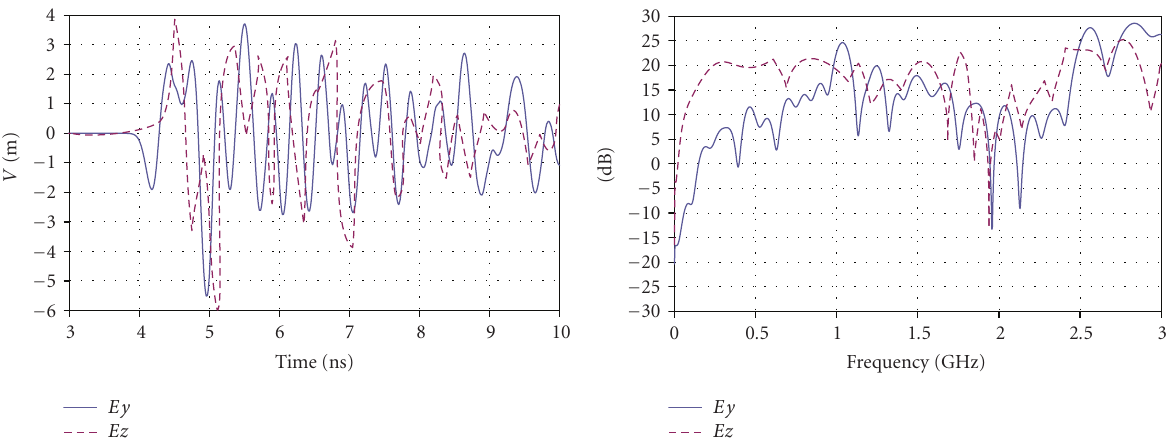
Figure 12: Radiated fields along the x -axis without corrugations.